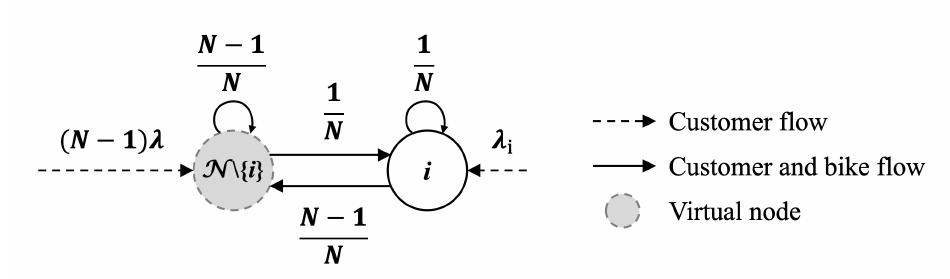
Figure 1. A reduced N -node network with the same probabilities and the same arrival rates at the nodes which are aggregated into a virtual node.